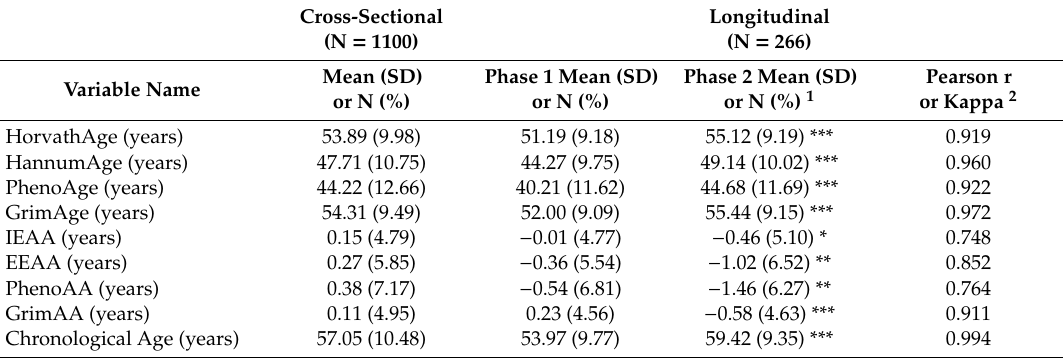
Table 1. Descriptive statistics of study participants from the Genetic Epidemiology Network of Arteriopathy